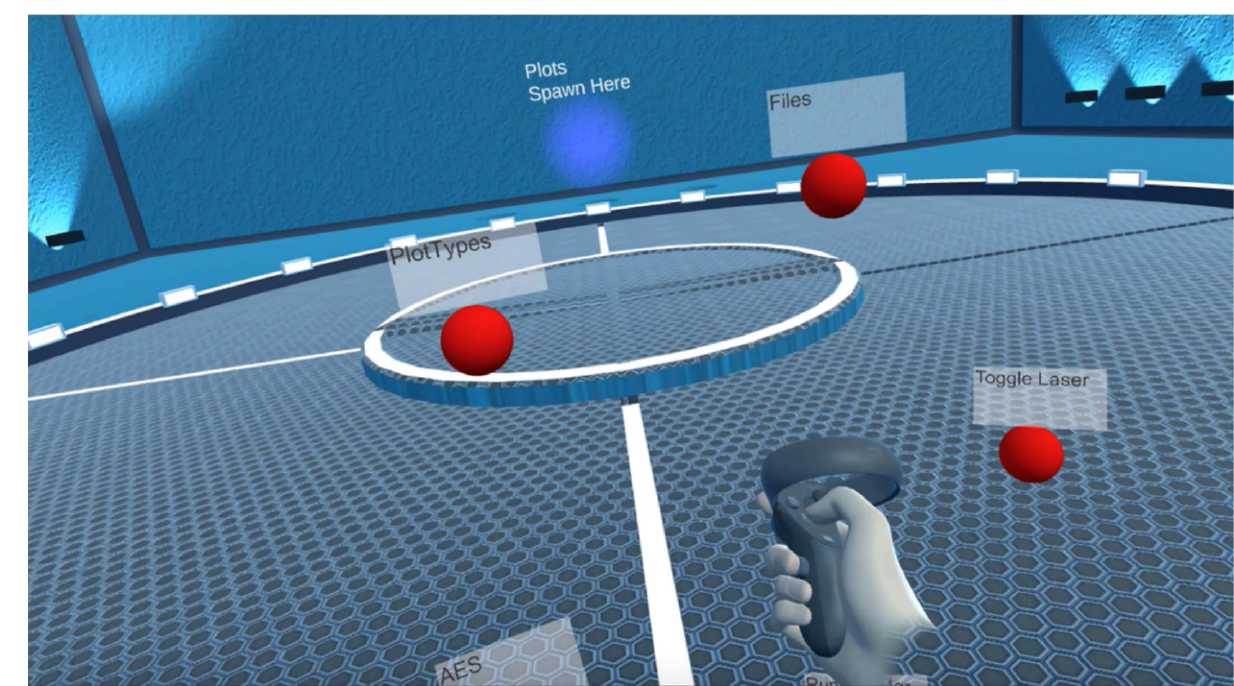
Figure 3. IVEE’s gesture ‐ based central menu system.